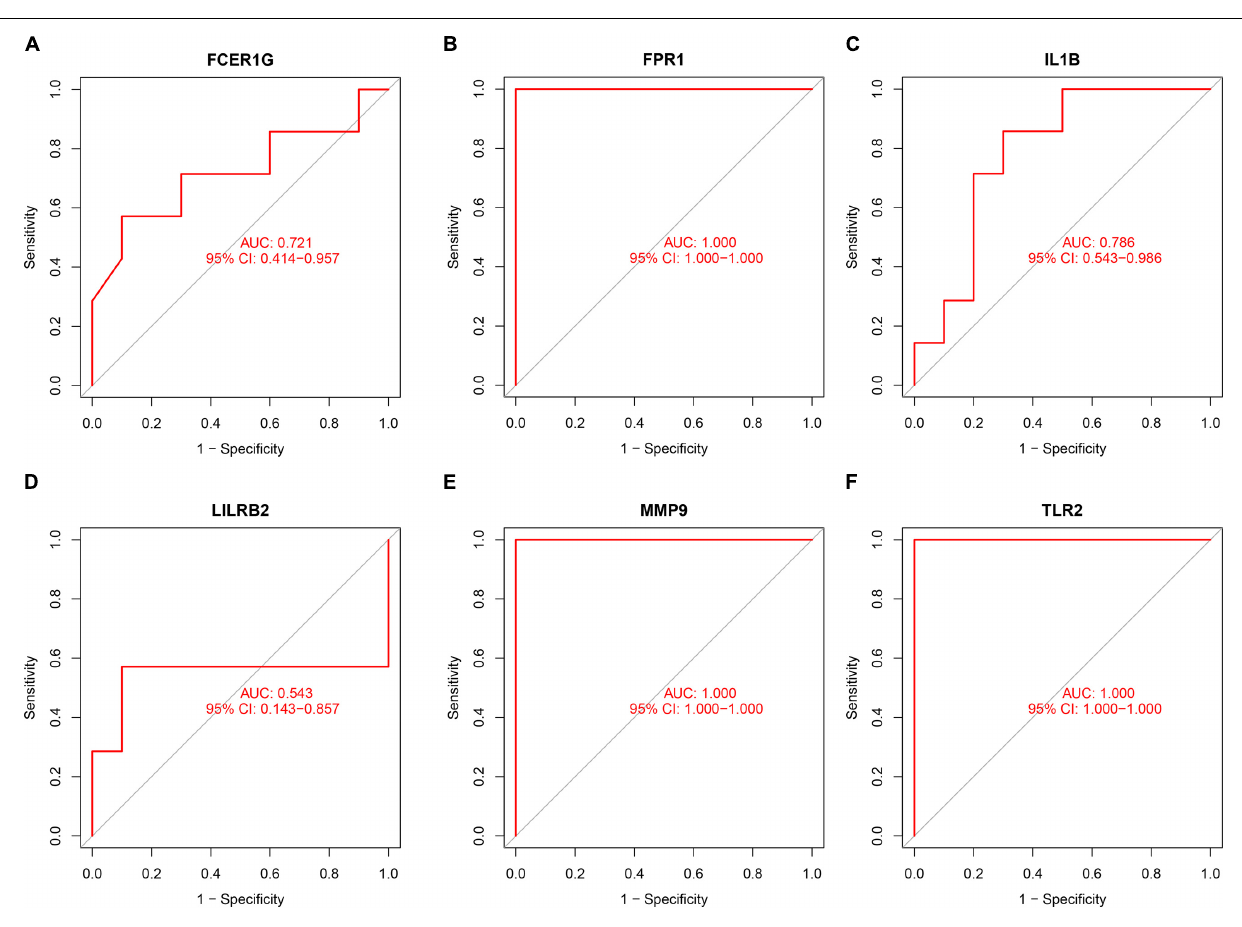
FIGURE 9 | Validation of the diagnostic value of hub genes in the GSE61144 data set. (A) Fc fragment of IgE receptor Ig (FCER1G), (B) formyl peptide receptor 1 (FPR1), (C) interleukin-1B (IL1B), (D) leukocyte immunoglobulin-like receptor subfamily B2 (LILRB2), (E) matrix metalloproteinase 9 (MMP9), and (F) Toll-like receptor 2